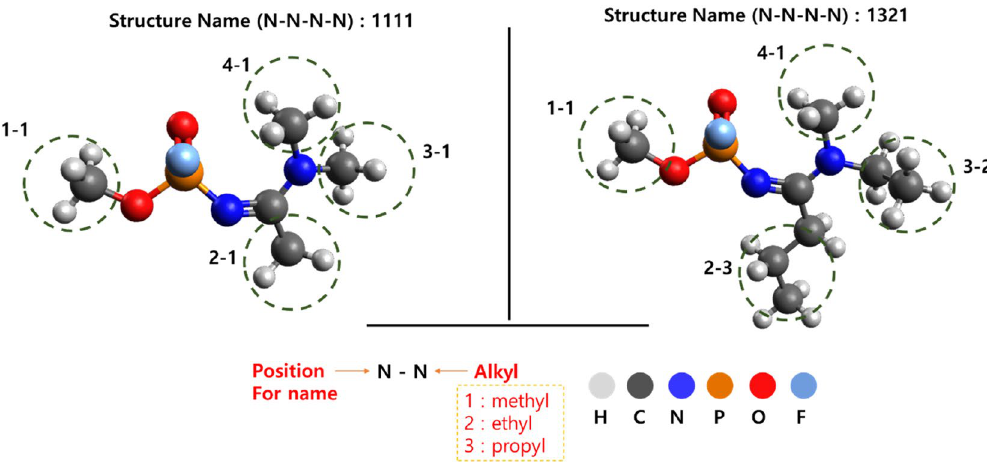
Figure 4. Method for name assignment of A-series Novichok candidates when the functional group is substituted with three alkyl groups (methyl, ethyl, and propyl). Chloroform was estimated for experimental sampling; therefore, the M06-2X/6-311 + G(2d,p) and MPW1PW91/6-311 + G(2d,p) functionals/basis set combinations were used for the DFT study.